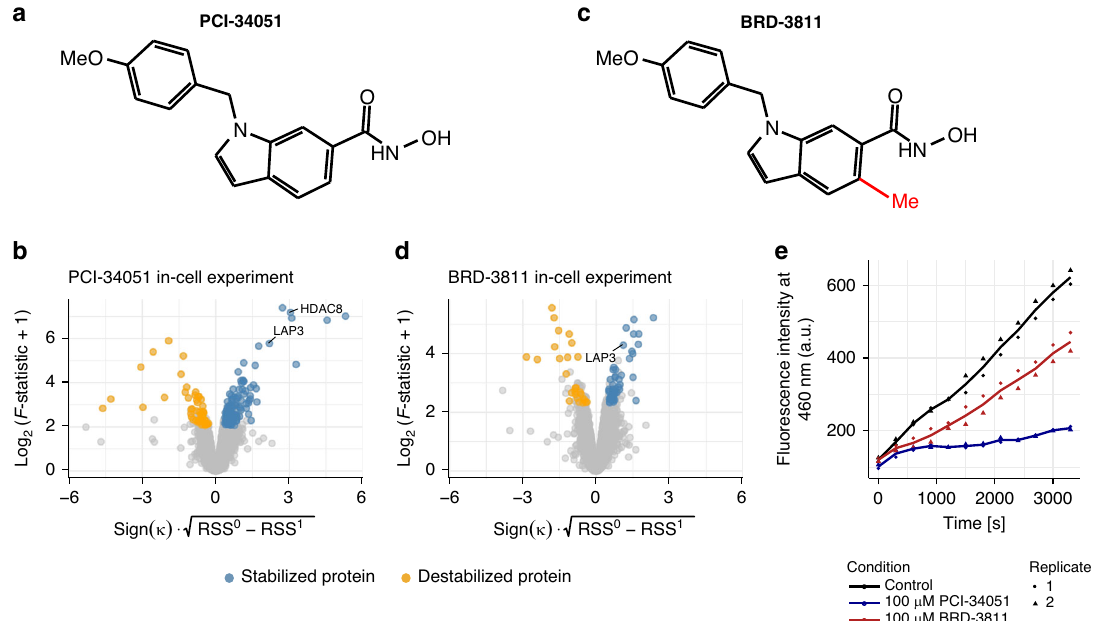
Fig. 4 DLPTP reveals LAP3 as a target of PCI-34051 and BRD-3811. a Chemical structure of the HDAC8 inhibitor PCI-34051. b Volcano plot of the 2D- TPP experiment with PCI-34051 in HL-60 cells. c Chemical structure of BRD-3811, an analog of PCI-34051 in which the Zn2 + chelating hydroxamic acid (HA) group is sterically hindered by a methyl group (highlighted in red). d Volcano plot of the 2D-TPP experiment with BRD-3811 in HL-60 cells. e Fluorescence intensity measured over time in a fl uorometric leucine aminopeptidase assay with recombinant LAP3 in the presence of PCI-34051, BRD-3811, or vehicle control. Axes in b and d are outlined in Fig.